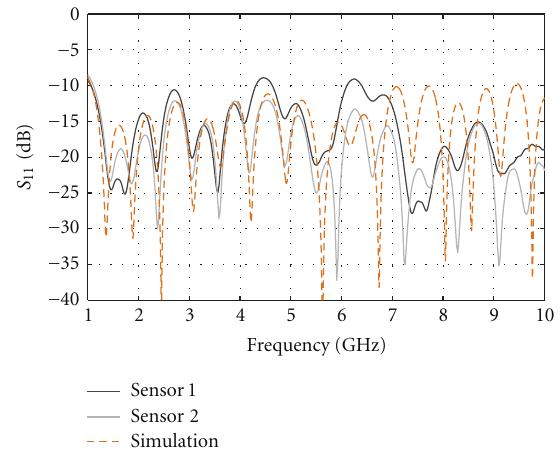
Figure 7: Reflection coe ffi cient measured for both sensors when immersed in 2% saline. Simulated counterpart is in dashed